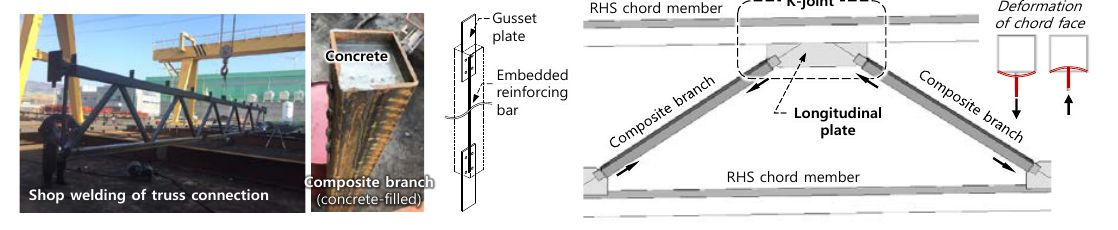
Figure 1. Rectangular hollow structural section truss for long-span building structures: ( a ) Rectangular hollow structural section (RHS) roof truss; ( b ) Longitudinal plate-to-RHS K-connection.